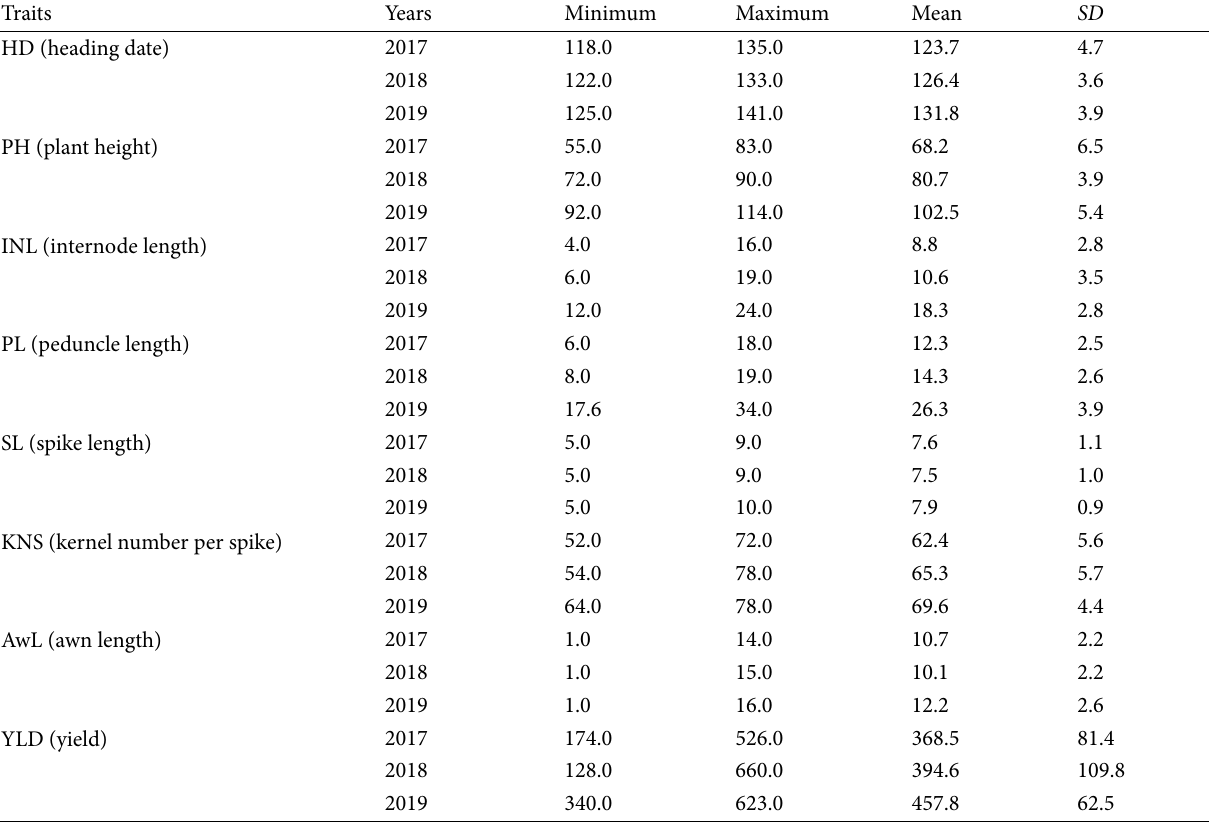
Table 3 Descriptive statistics of the studied traits. Traits